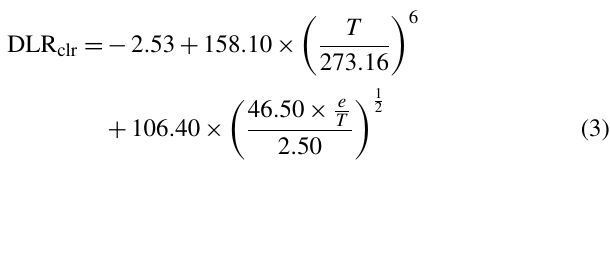
> 37 . 5 W m − 2 and R 2 < 0 . 75) if the water vapor effect